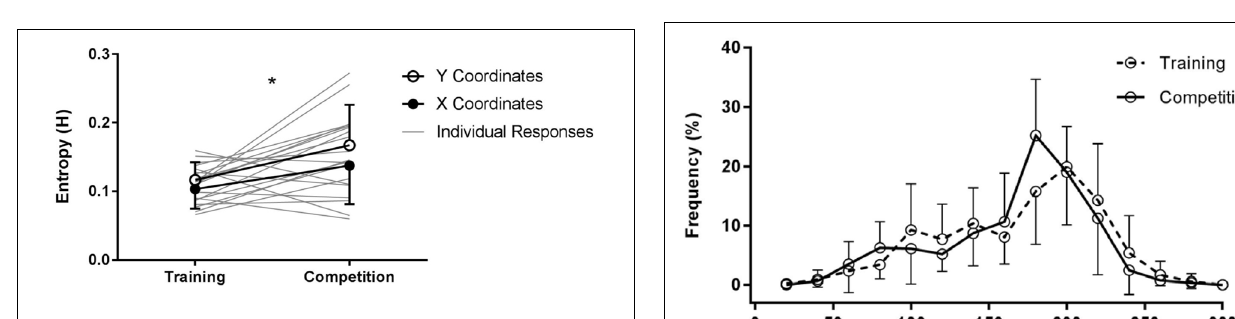
FIGURE 3 | Predictability of movement trajectories assessed using sample entropy (H) for training and competition fights. Mean results and standard deviations are presented in bold for both x and y coordinates, individual results are presented in light gray. ∗ Indicates a significant main effect for condition ( p < 0.05).